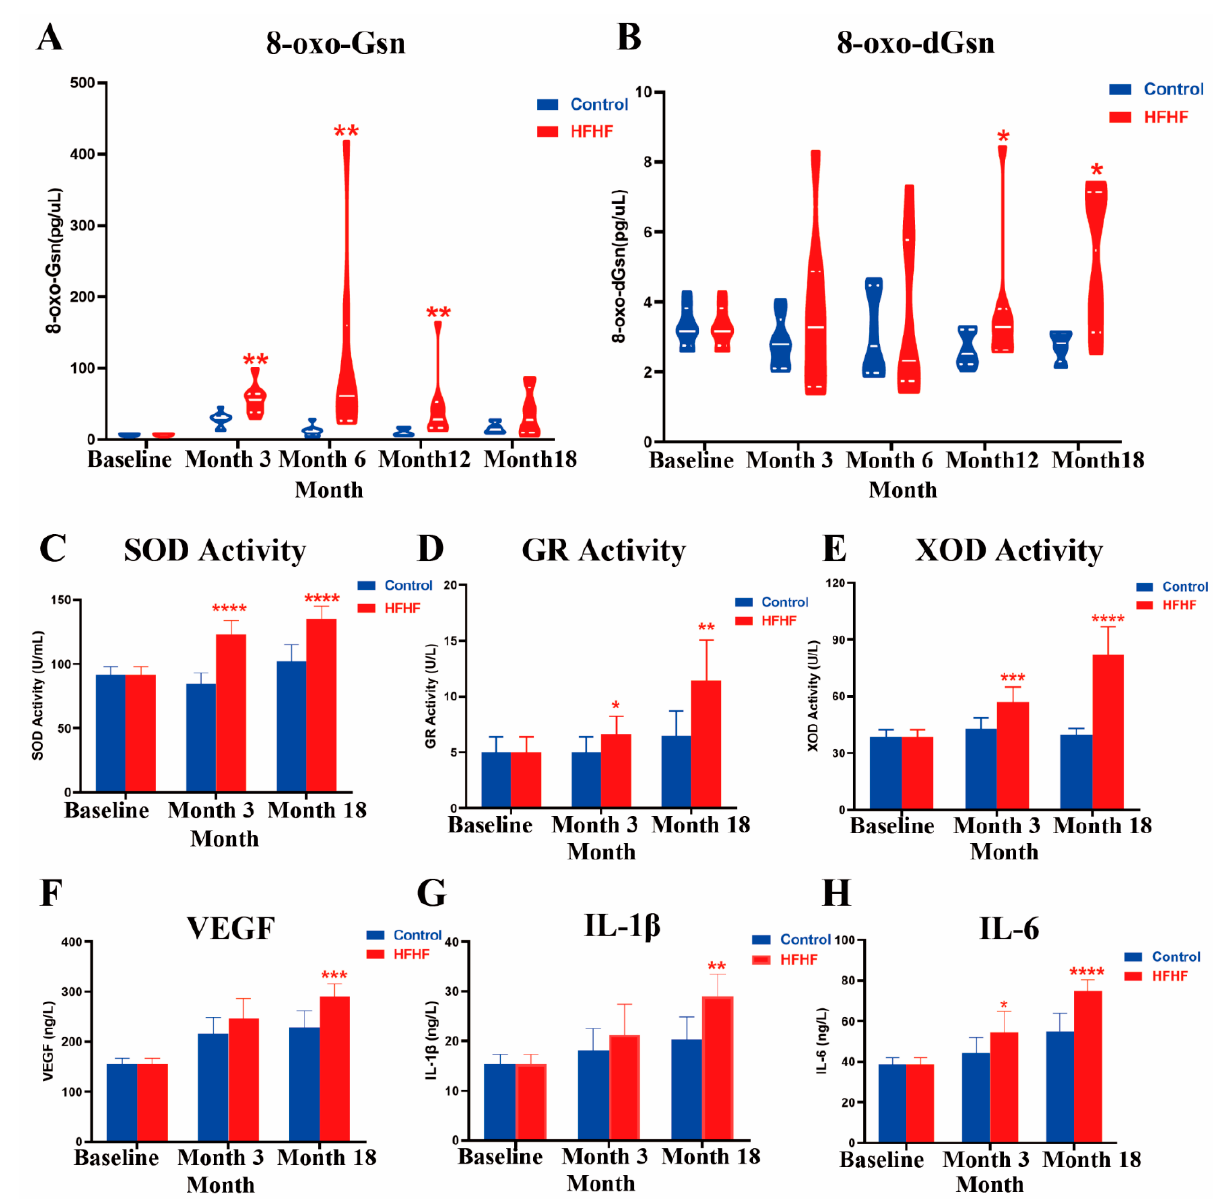
Figure 4. Changes in oxidation and inflammation levels during this study. Evolution of 8-oxo-Gsn ( A ) and 8-oxo-dGsn ( B ) during the study for the normal diet (control, blue) and high-fat, high-fructose diet (HFHF, red) groups. Results are shown as the median (interquartile range). ( C , D ) Effects of diet on SOD ( C ), GR ( D ), and XOD ( E ) activity at the beginning (baseline) and after 3 (month 3) and 18 (month 18) months of control and HFHF diet. ( F – H ). Effects of diet on VEGF ( F ), IL-1 β ( G ), and IL-6 ( H ) during the study at the beginning (baseline) and after 3 (month 3) and 18 (month 18) months of treatments. Results are shown as the mean ± SD. * Significant results versus the age-matched control group: * p < 0.05, ** p < 0.01, *** p < 0.001, **** p <